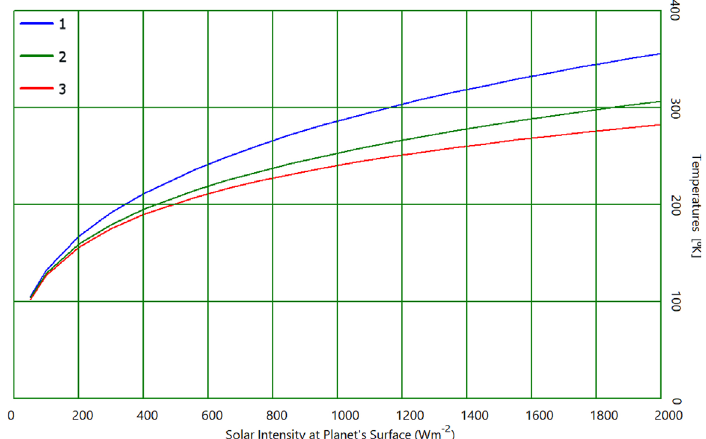
Fig. 10. Characteristic temperatures of a solid planet with an inert atmosphere. 1 – mean air temperature approximately 1.2 m above the surface skin, 2 – effective emission temperature of the sur - face skin and 3 – mean temperature of the surface